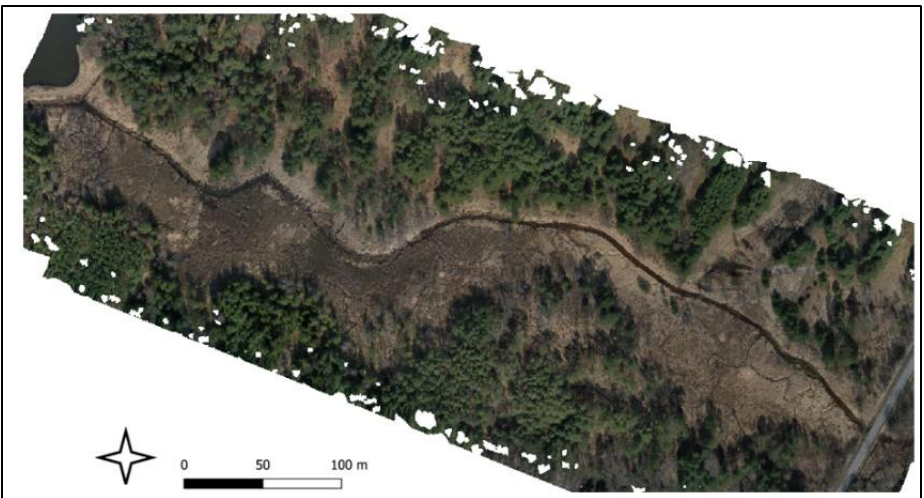
Figure 3. Orthophotomosaic illustrating the subject of the analyses and the surrounding area; source: orthophotomosaic created by Szymon Sobura.